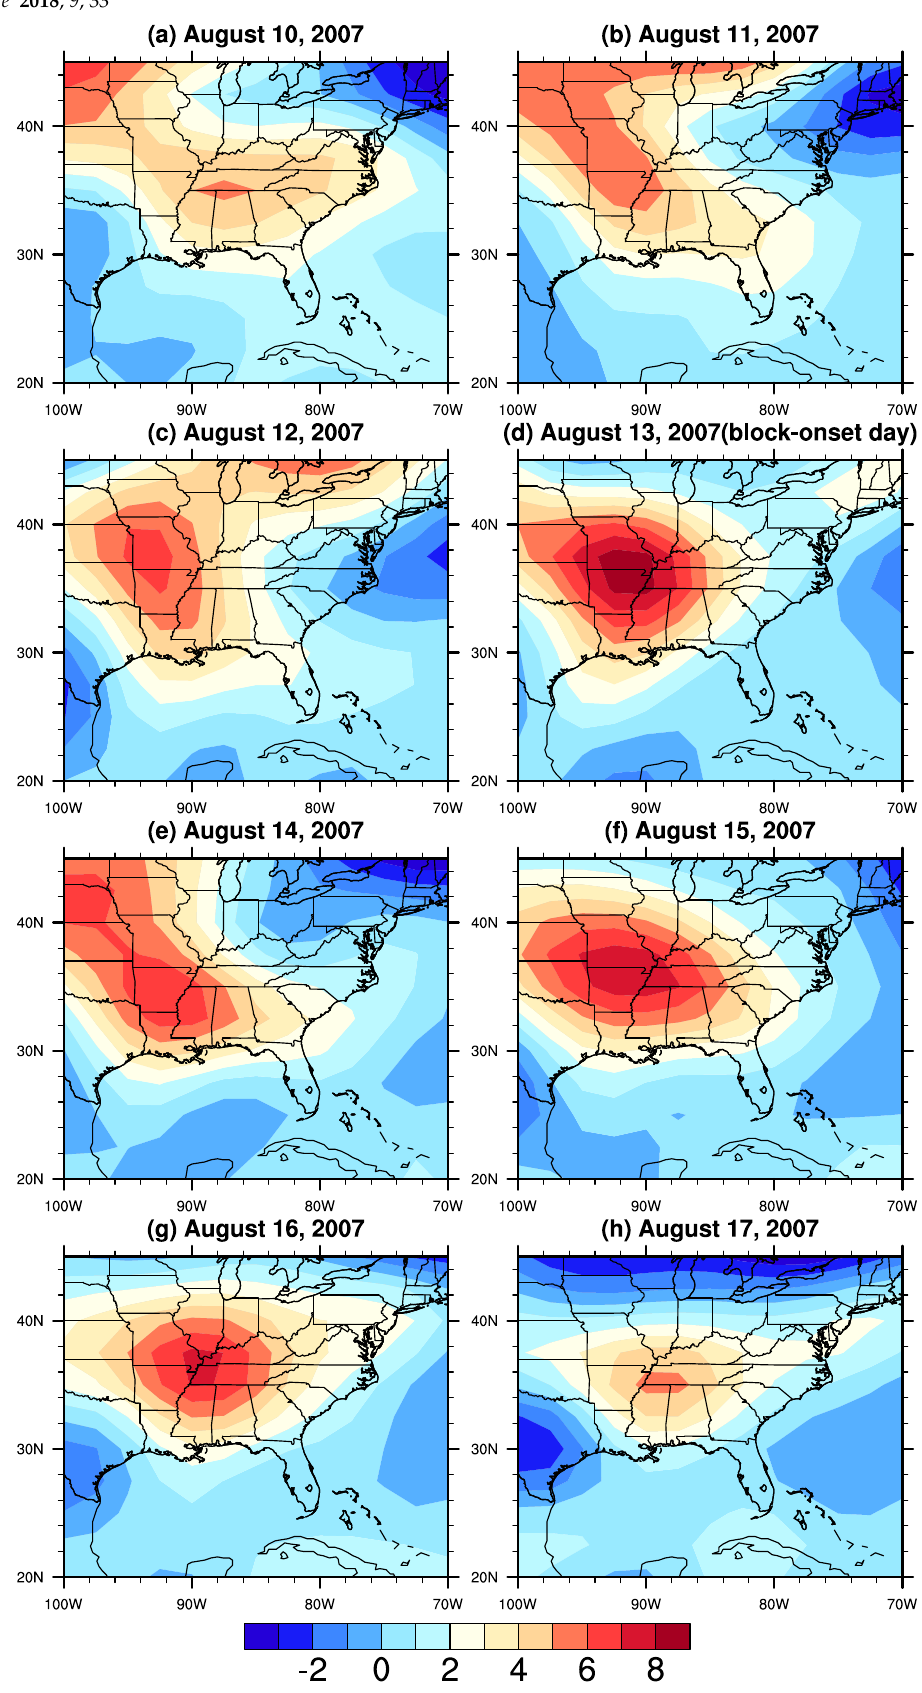
Figure 6. 1000-mb temperature anomaly from the long-term mean temperature from 10 August 2007 ( a ) to 17 August 2007 ( h ), in units of ◦ C, during the evolution of August 2007 blocking